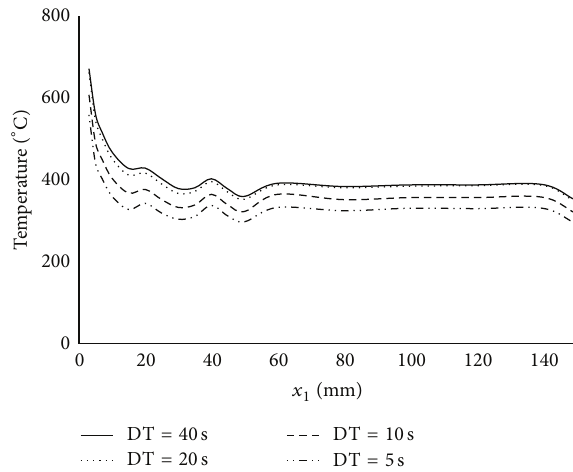
Figure 9: Simulated temperature values for different plunge dis- tance from the edge.